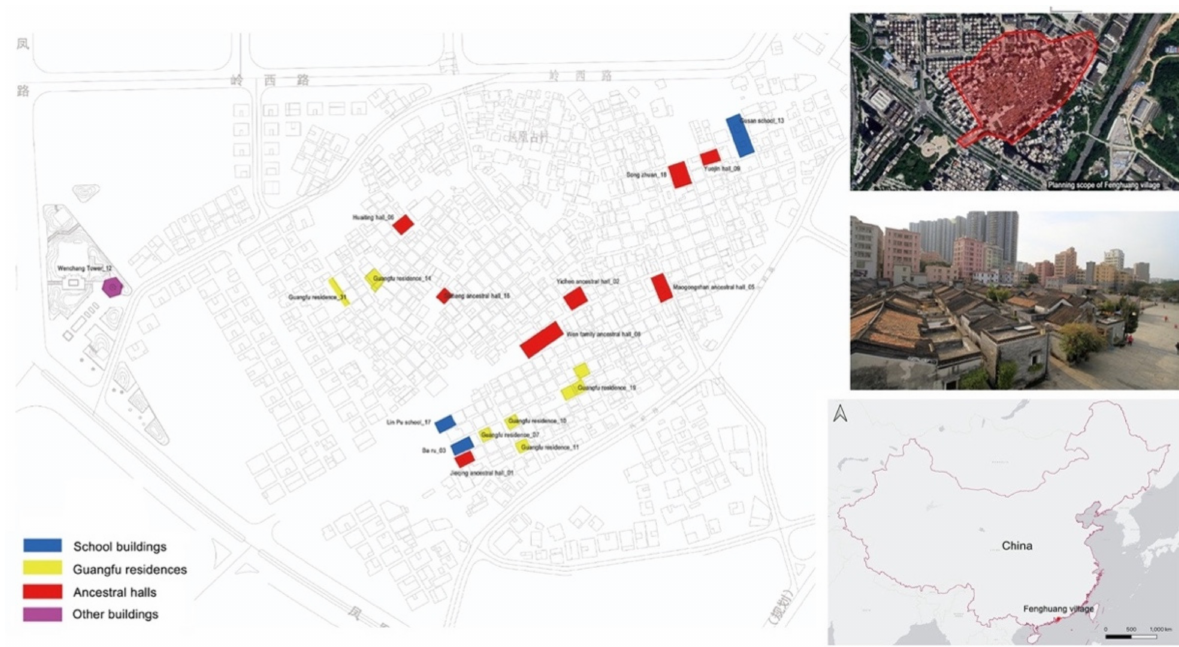
Figure 1. Location of Fenghuang village. The distribution of different kinds of buildings inside of the village is shown by the map, including school buildings, Guangfu residences, ancestral halls, and other